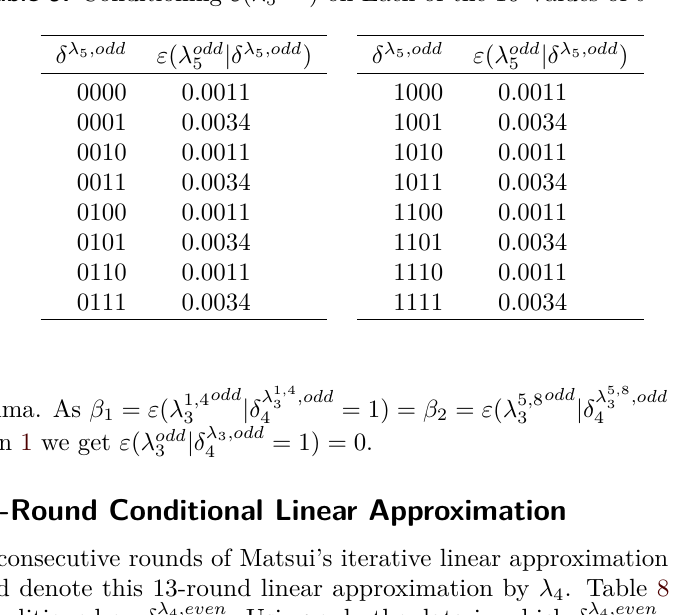
Table 9: Conditioning ε ( λ 5 odd ) on Each of the 16 Values of δ λ 5